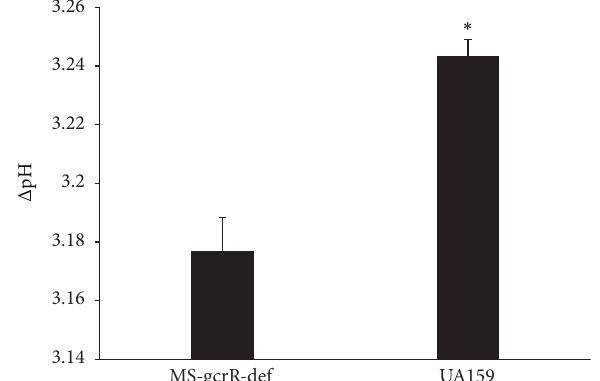
Figure 4: For in vitro acid production, the initial pH of the culture was measured at 7.3 by using a pH meter. Each sample was repeated three times. ∗ Significant differences were found between UA159 and MS-gcrR-def ( 𝑃 < 0.05